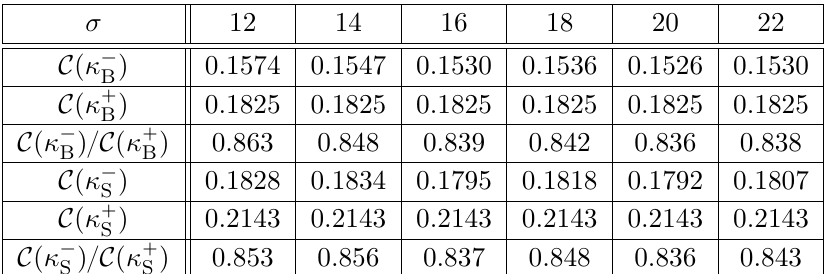
Table 1 . The values of C p κ ˘ entropy density S { L . We note that the relative error of the fitted parameter C p κ ˘ order 10 ´ 3 ´ 10 ´ 4 .